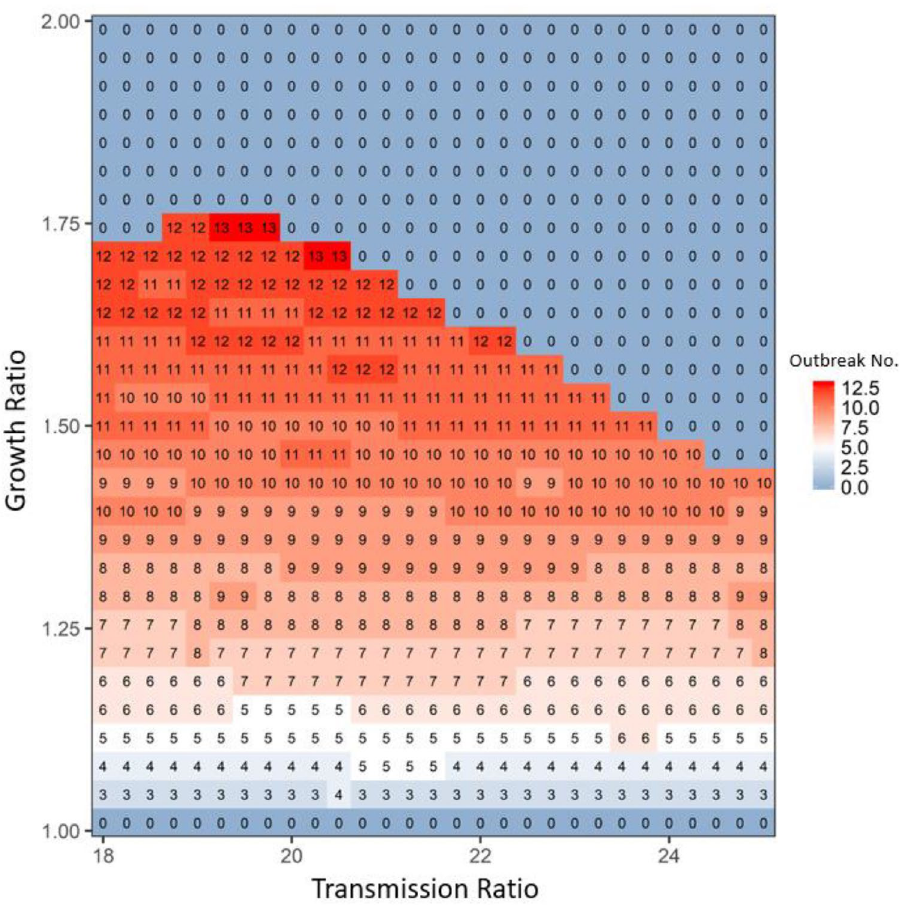
Figure 3. The average disease outbreak numbers in the last 25 generations (total simulated generations are 50) under the influences of growth ratio and transmission ratio for Wild type at patch #30, where robust type provides the baseline growth rate and transmission rate. The color trend with numbers represent the trend of disease outbreak numbers: from blue to white to red, outbreak numbers increase. All the other parameters are: r R = 0.15, r Wd = r Rd = 0.01, r Wr = r Rr = 0.2, α W = α R = 0.05, μ W = μ R = 0.0005, γ W = γ R = 0.05, β RR = β WR = 0.000005 and m ( k , j ) = 0.000008. In focal patch #1, the initial susceptibles of both types are 200, infecteds are 5, and recovereds are 0. Other patches show similar